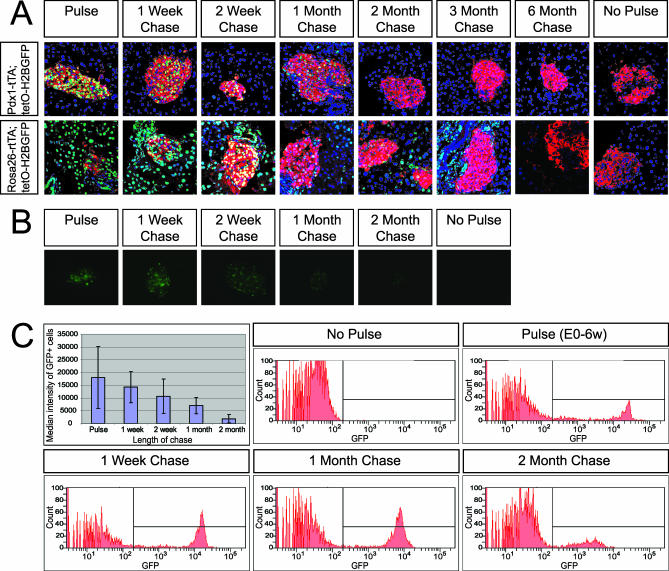
Uniform Loss of Label in Adult β Cells Following Pulse–Chase with Pdx1-tTA; tetO-H2BGFP and Rosa26-rtTA; tetO-H2BGFP Mice(A) Label retention present in the adult pancreas (insulin expression shown in red) following a chase period of up to 6 mo. Exposure-matched images. Original magnification, 400×.(B) Whole islets of Rosa26-rtTA; tetO-H2BGFP pulse–chase animals prior to dissociation and FACS. Exposure-matched images. Original magnification, 100×.(C) FACS plots of dissociated islets of Rosa26-rtTA; tetO-H2BGFP pulse–chase animals. Median intensity of GFP-positive cells versus length of chase shown in graph.